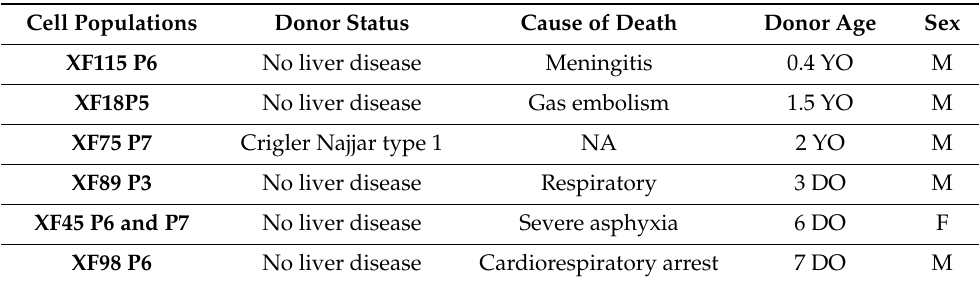
Table 1. Characteristics of the donors used in the current study.